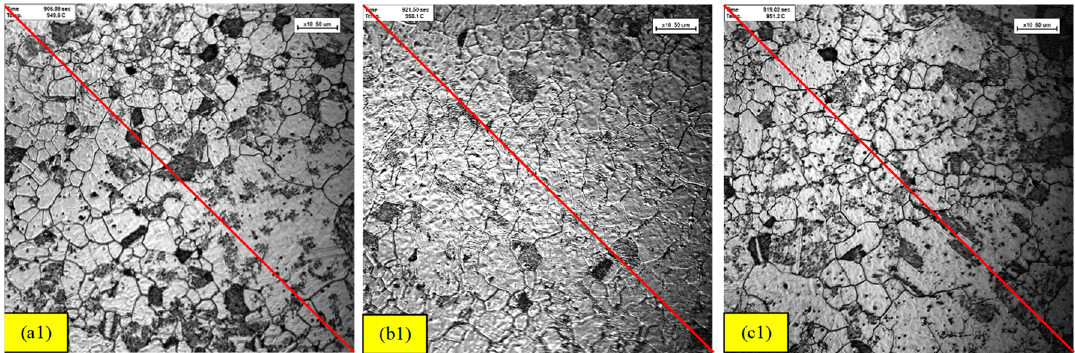
Figure 2. In-situ observation by confocal microscopy at the last seconds before quenching process. Temperature at around 950 °C before different quenching rate ( a1 ) 1 °C/s, ( b1 ) 6 °C/s and ( c1 ) 50 °C/s.